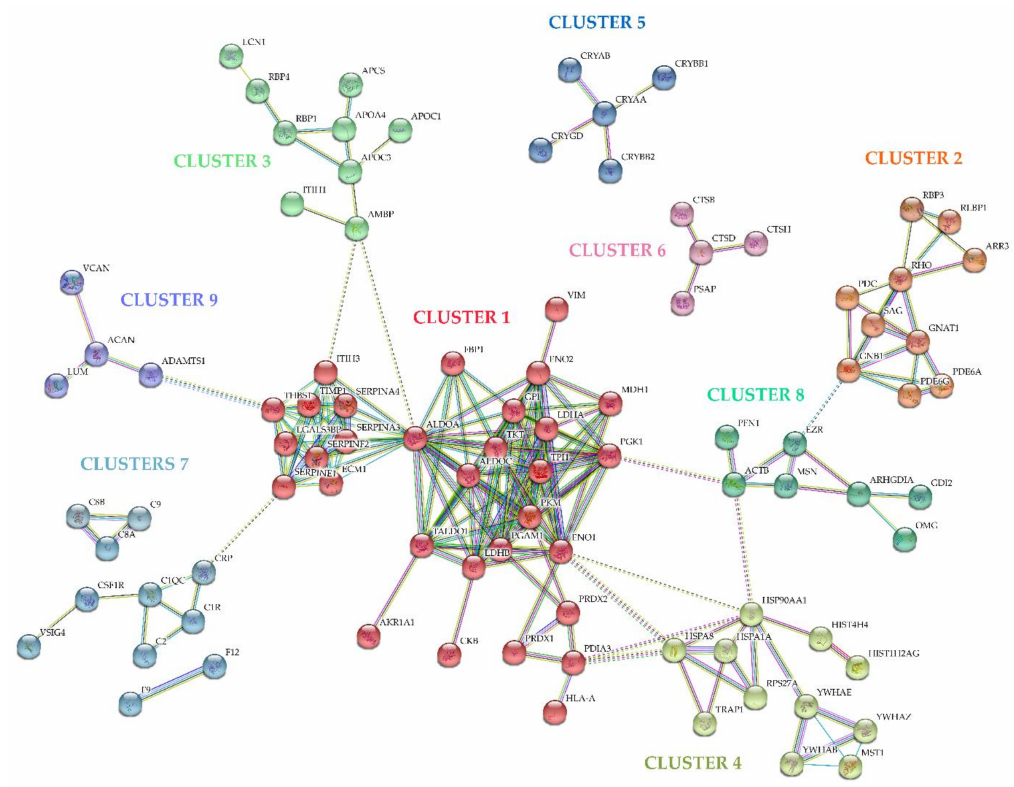
Figure 2. Protein-protein interaction network of the proteins found differentially expressed in RRD, based on interaction evidence, predicted using STRING 10. The protein-protein interaction network (PPI) network was grouped into 11 relevant protein clusters using the ECM clustering option provided by